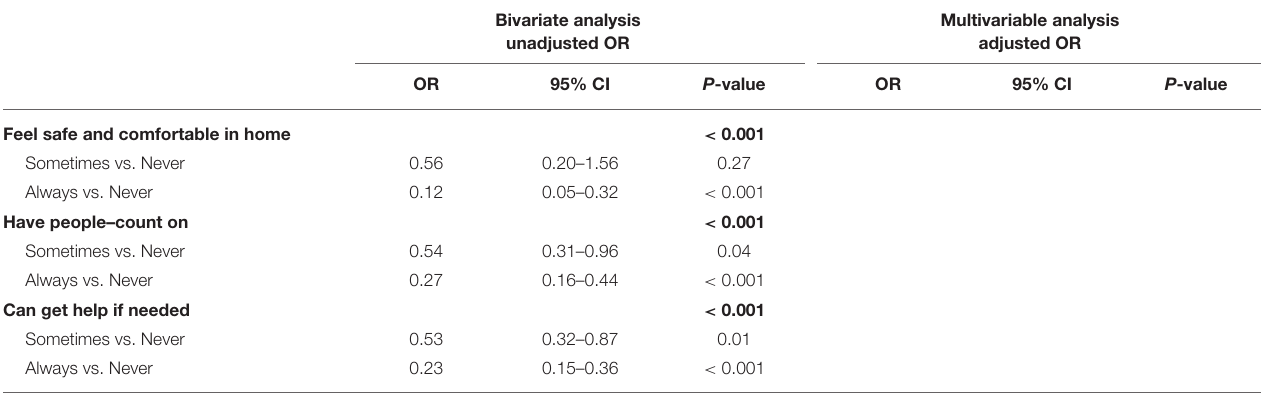
many contributors, potentially acting as an amplifier of